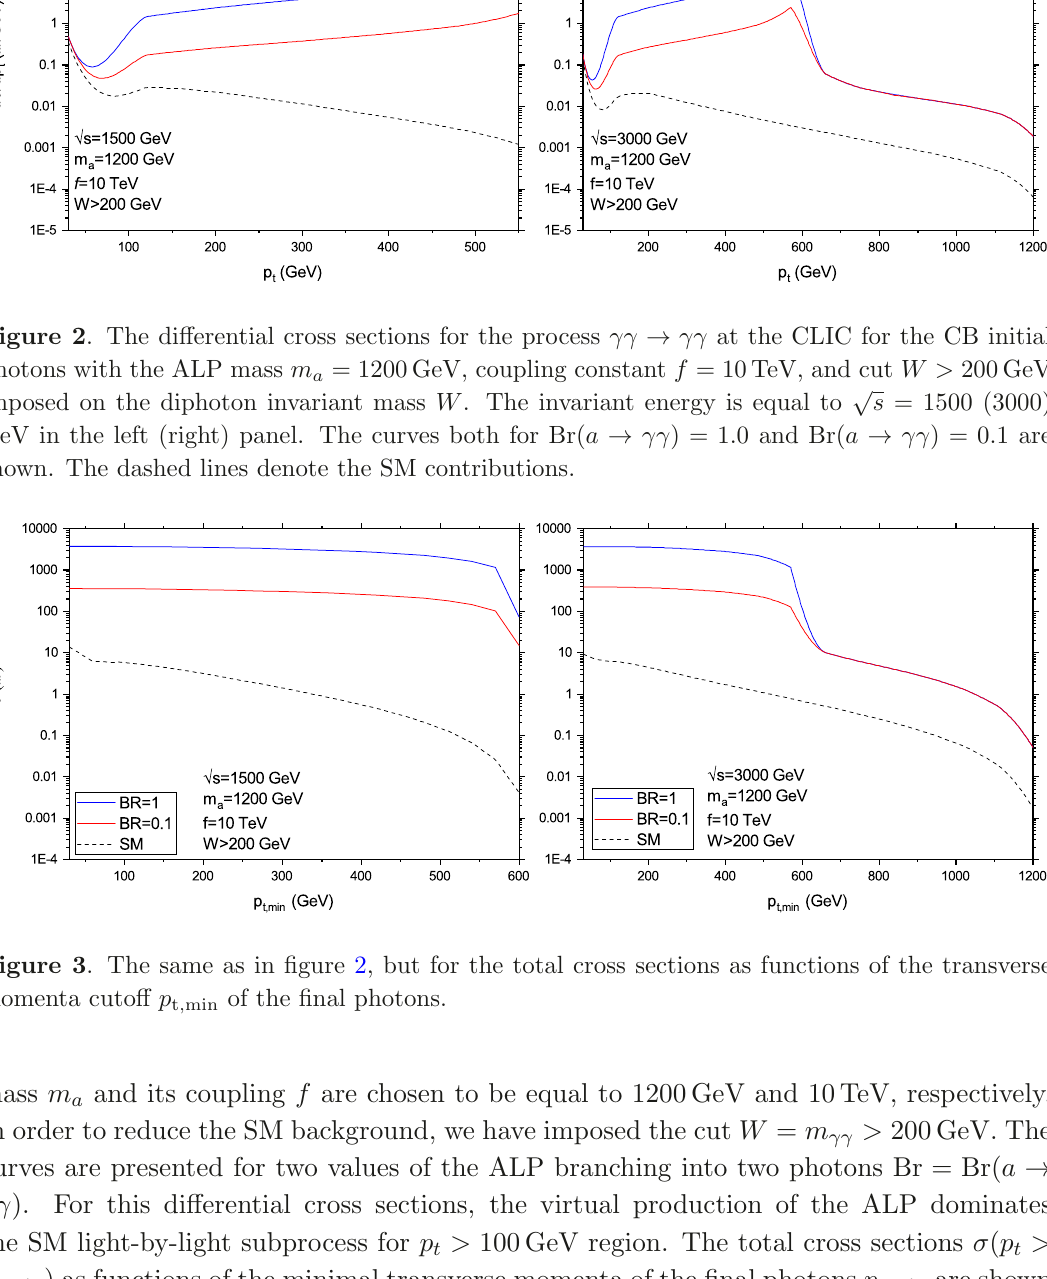
Figure 3 . The same as in figure 2, but for the total cross sections as functions of the transverse momenta cutoff p t , min of the final